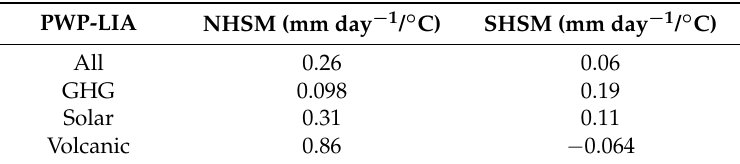
Table 2. Simulated differences of monsoon-mean precipitation (including Northern Hemisphere summer monsoon and Southern Hemisphere summer monsoon) between PWP and LIA for per Celsius degree temperature